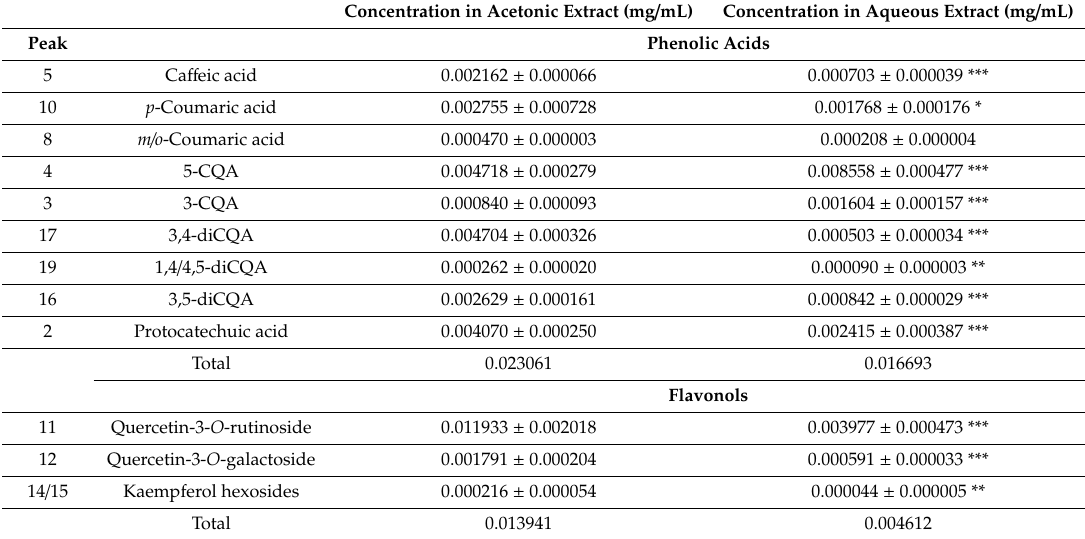
Table 3. Quantification of polyphenols-rich acetonic and aqueous extracts from A. borbonica by HPLC-HESI-MS. The analysis was performed using a Q-Exactive ™ Plus mass spectrometer at a concentration of 40 g / L. The concentrations of the di ff erent compounds were expressed as ng / mL. Data are the mean ± SD of three independent experiments. * p < 0.05, ** p < 0.01 ***, p < 0.001 (vs. 40 g / L